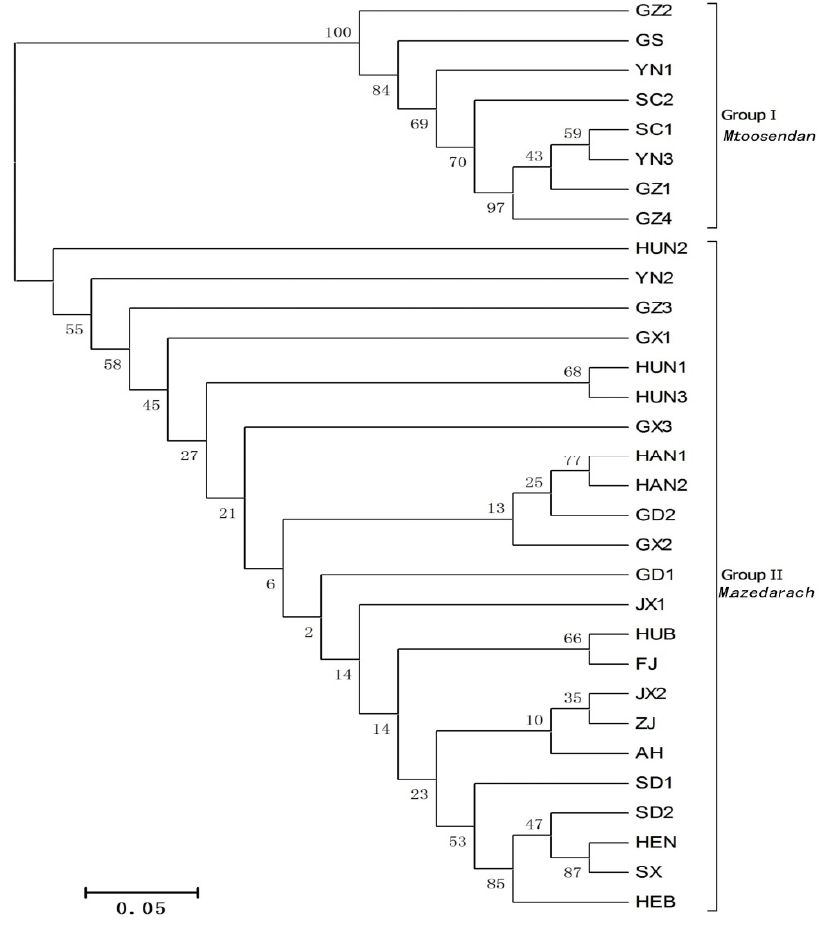
Figure 4. Neighbor-joining dendrogram of the 31 Melia Figure 4. Neighbor ‐ joining dendrogram of the 31 Melia provenances.